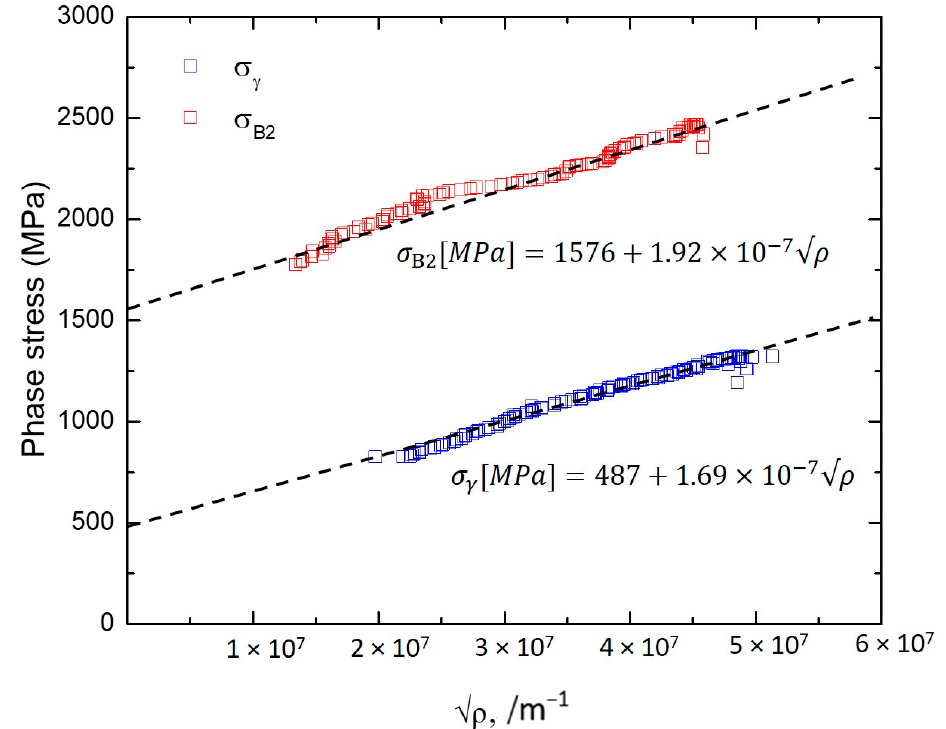
Figure 12. The phase stresses of austenite phase (blue square) and B2 phase (red square) during tensile deformation are plotted as a function of the square root of their dislocation densities. Good linear relationships between the phase stress and dislocation density are recognized, suggesting that the incremental phase stress in each constituent phase during tensile deformation can be explained by dislocation accumulation. / m − 1